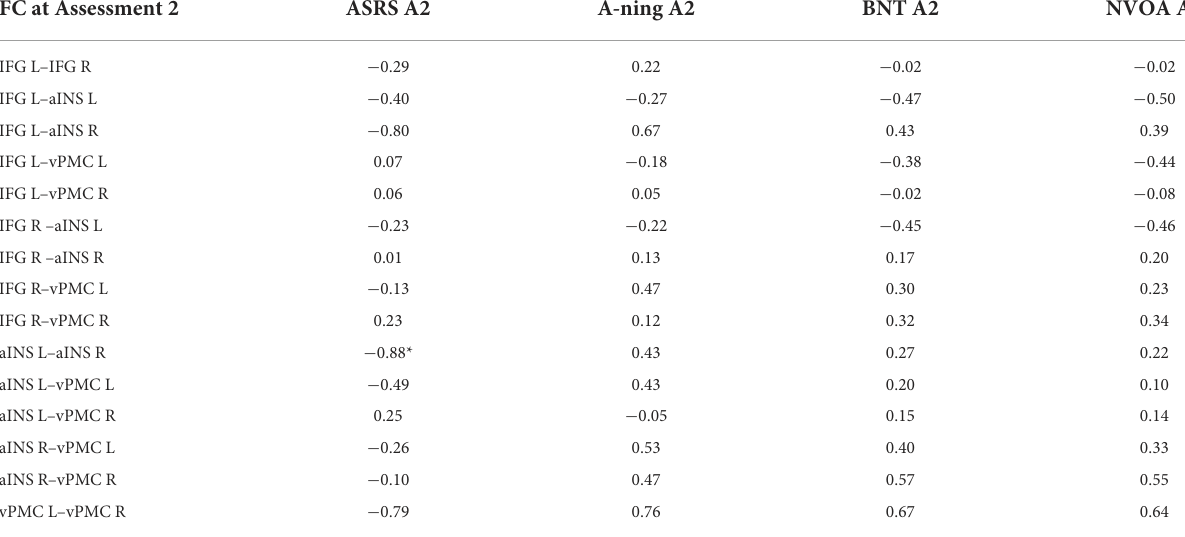
TABLE 8 Relation between FC and behavioral results at the second assessment